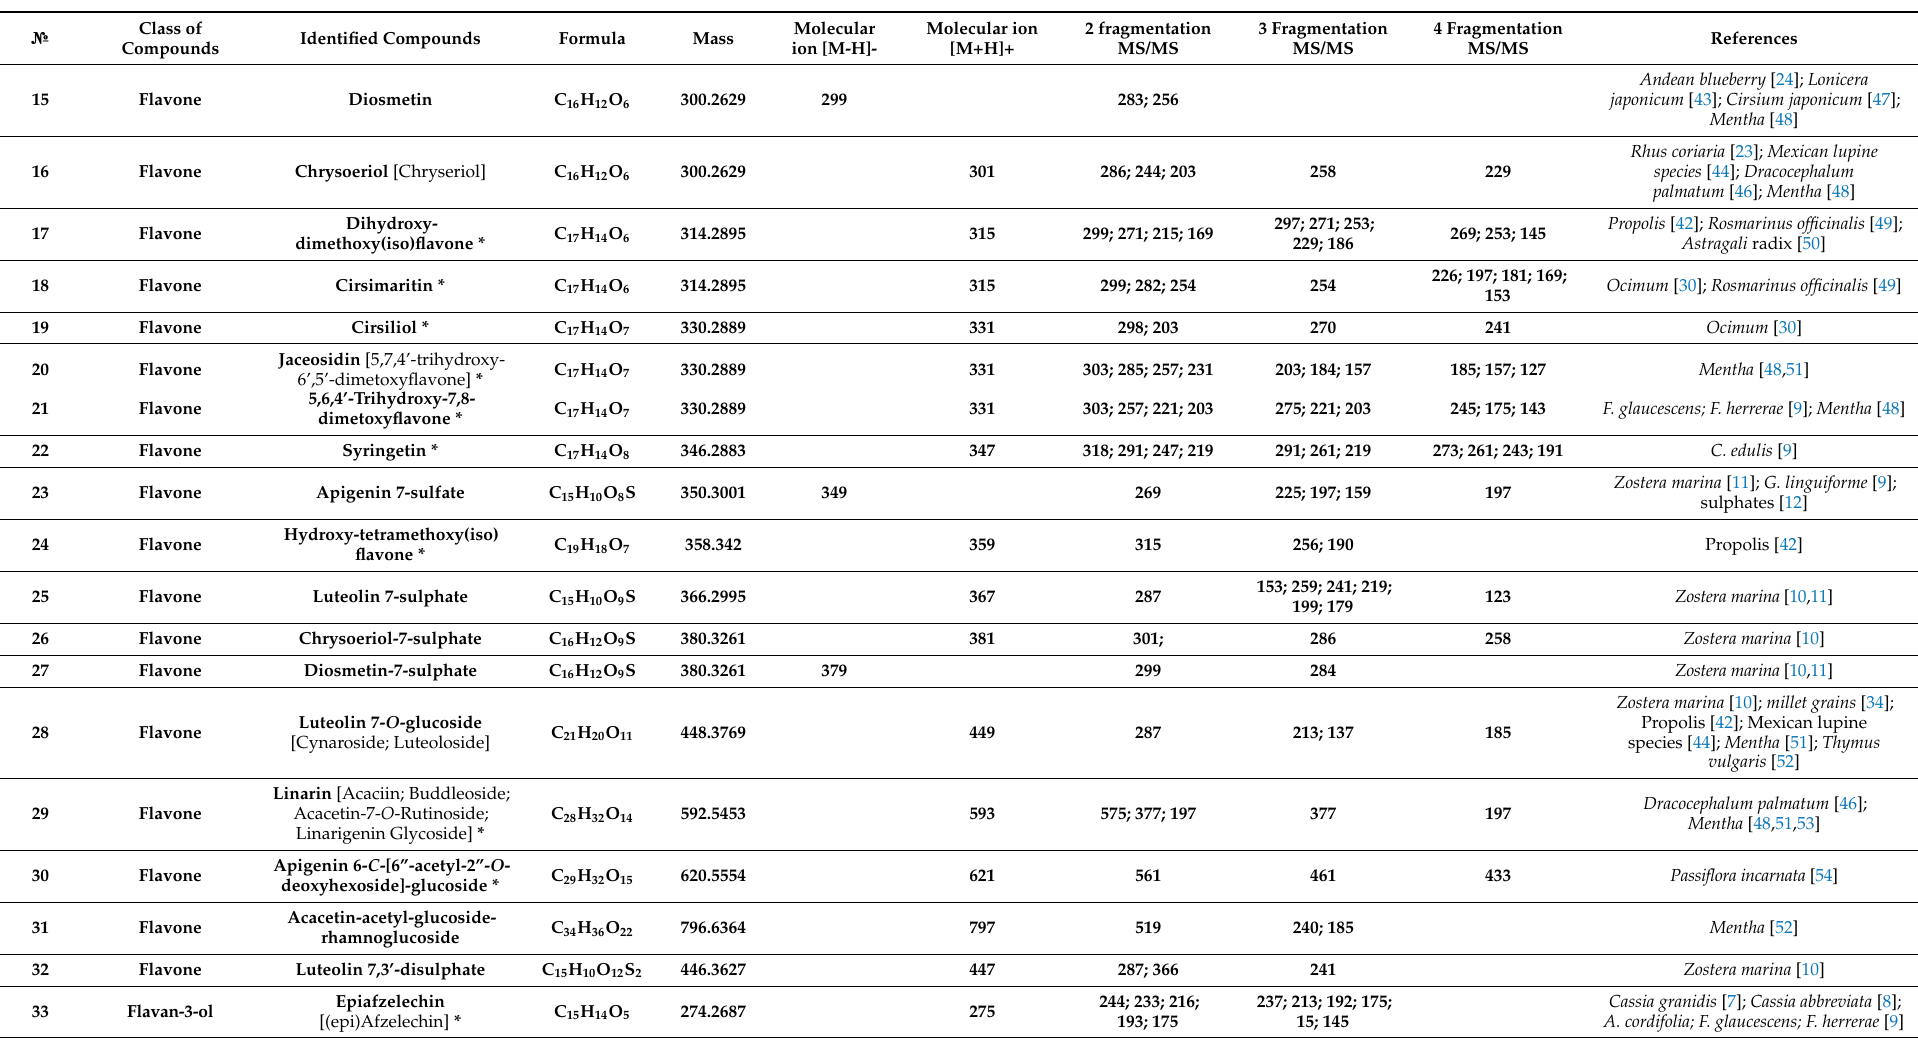
Cassia granidis [7]; Cassia abbreviata [8]; A. cordifolia; F. glaucescens; F. herrerae